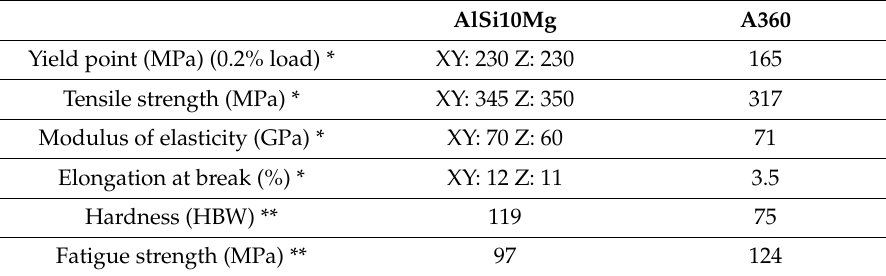
Table 2. Comparison of AlSi10Mg material, used for 3D printing, and similar A360 aluminum alloy, used in foundry